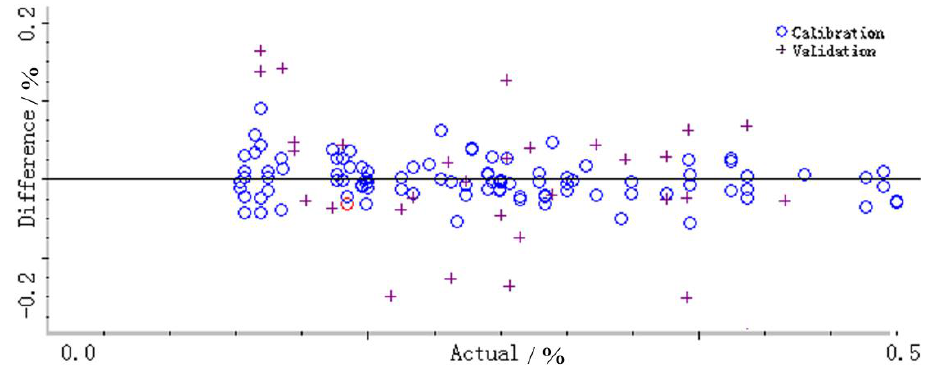
Figure 5. Error distribution. represents calibration; + represents validation.